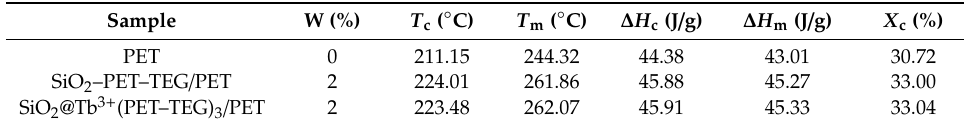
Table 4. Thermodynamic performance of composites.